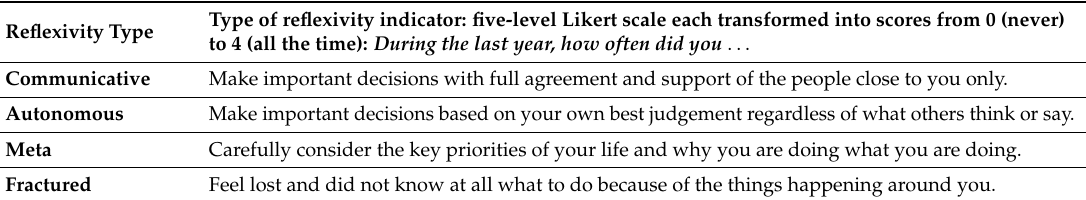
Table 1. Statements indicating different reflexivity